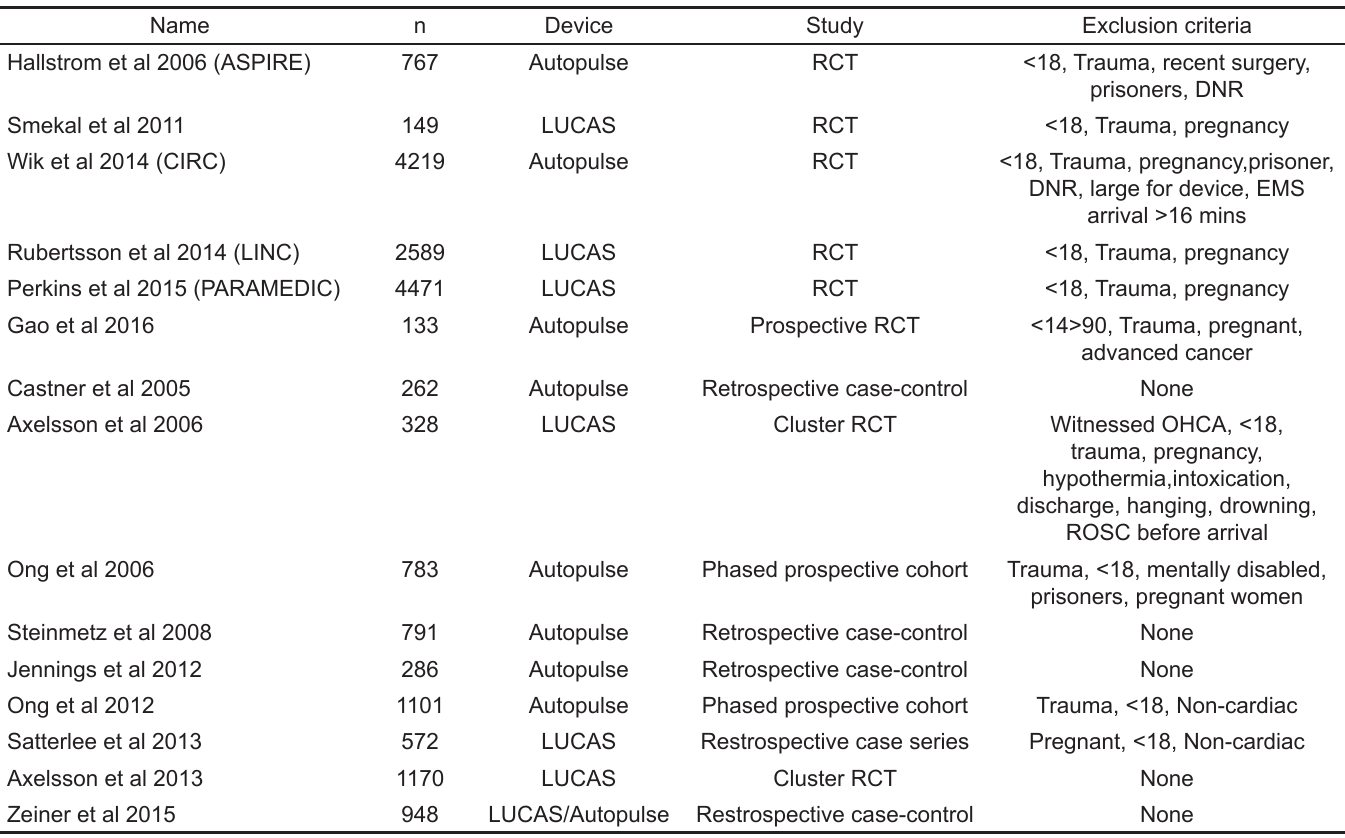
Table 1. Types of studies